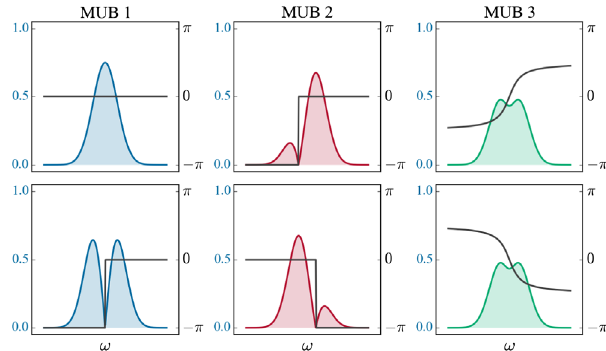
FIG. 3. The columns show the three MUBs for a TM qubit, with the fundamental TM shapes being a zeroth- and first-order Hermite-Gaussian pulse, respectively. The colored areas are the spectral amplitude, whereas the dark lines are the spectral phases of the TMs; the color coding corresponds to Fig. 2(b). Note that in this case, the qubit is encoded in the leftmost